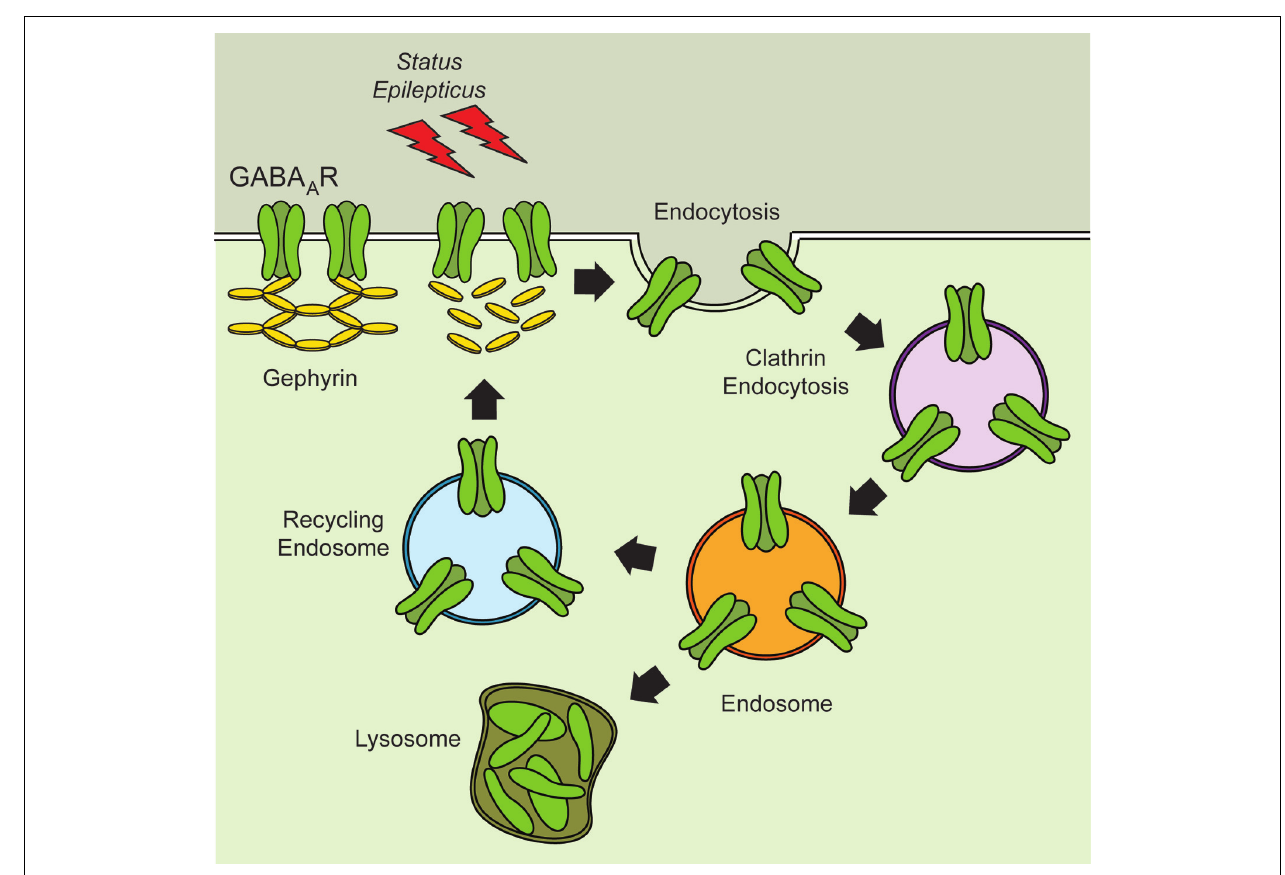
GABA A R and reduce the stability of receptors present at the plasma membrane. Reduced expression of GABA A R at the plasma membrane may contribute to the increased excitability observed during